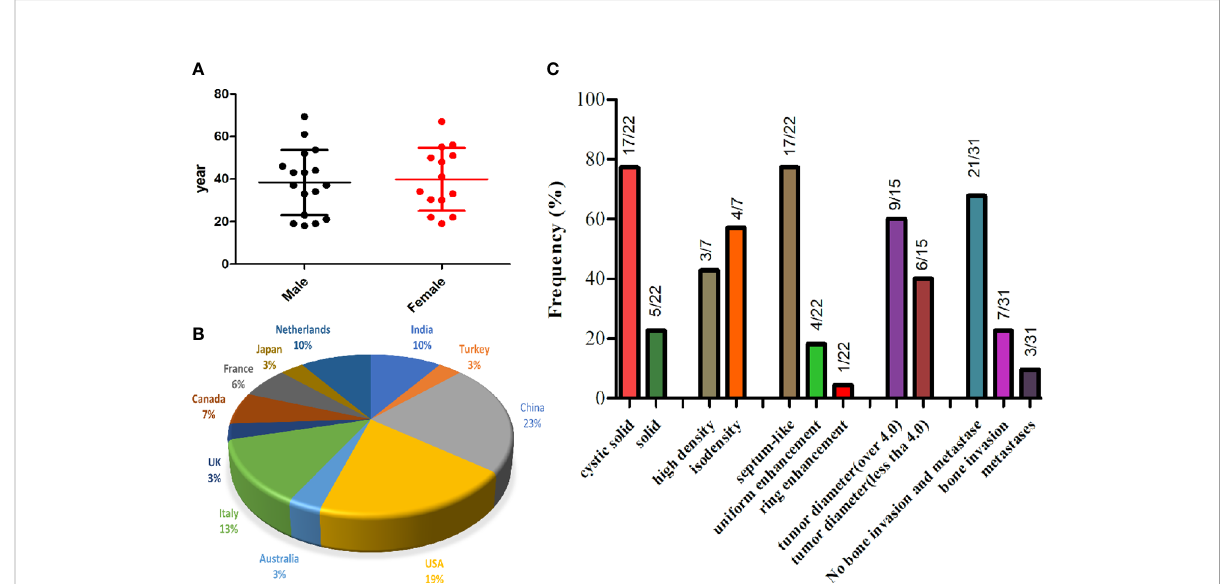
FIGURE 4 The gender and age distribution (A) and country proportion (B) of 31 adult patients with primary intracranial EWs/PNET, and imaging features of primary intracranial EWs/PNET (C) .